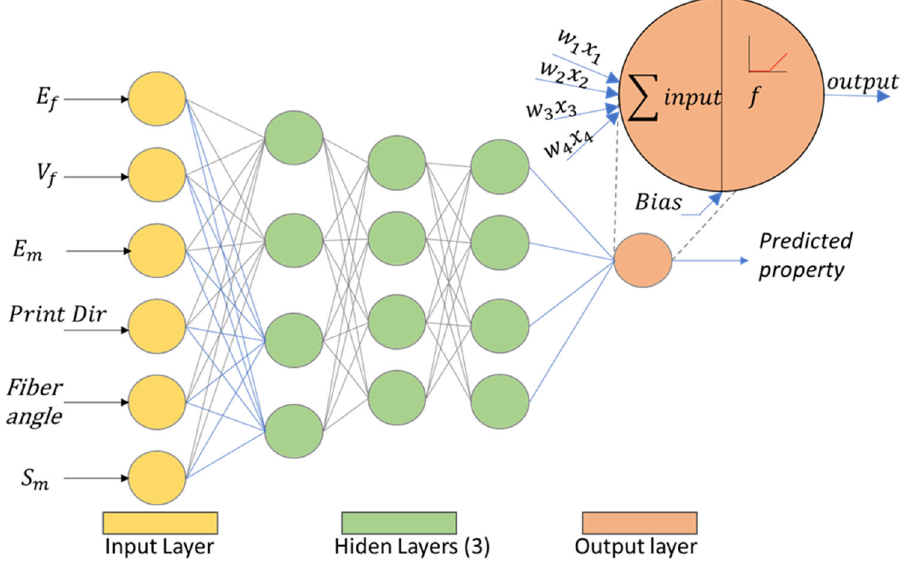
Figure 1. Schematic of the artificial neural network.